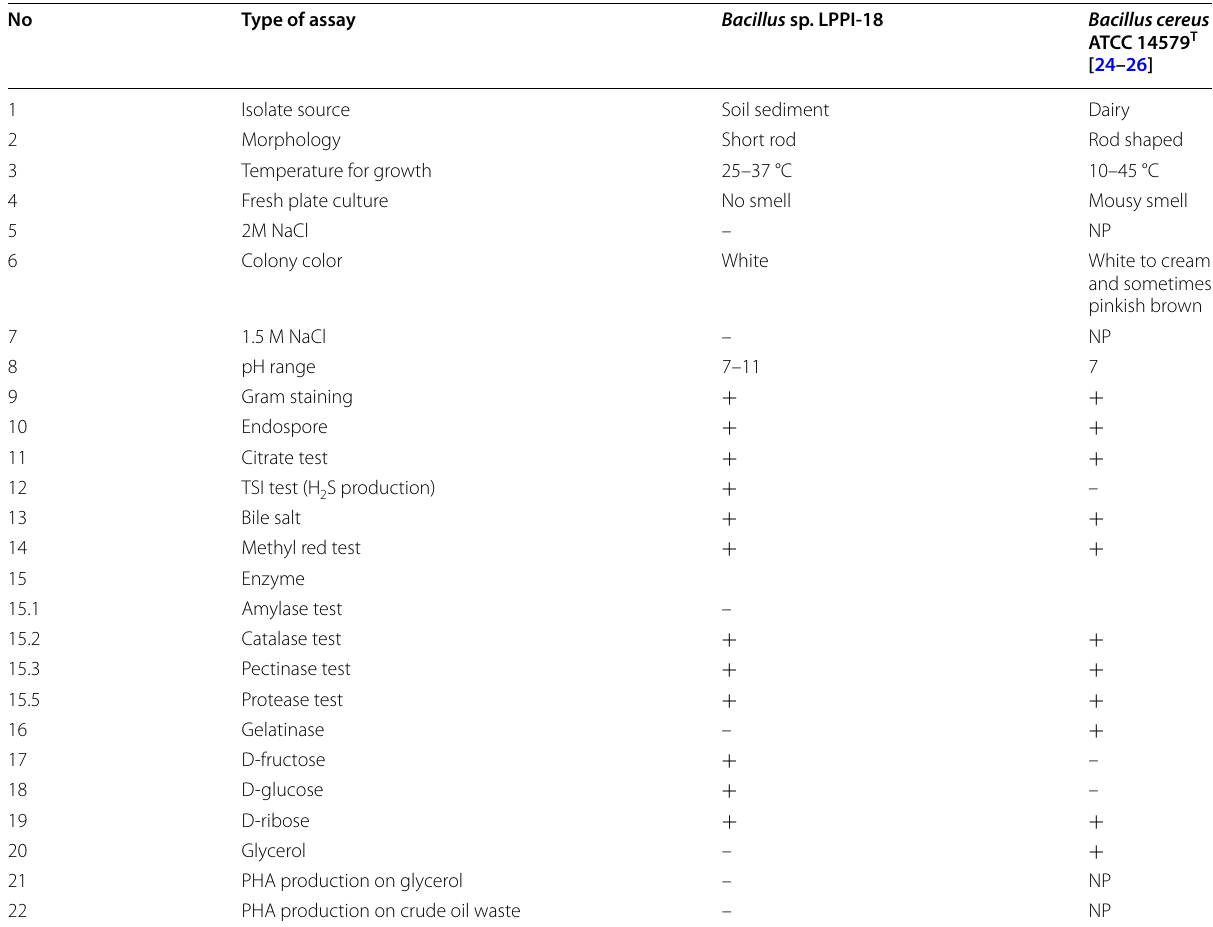
Table 1 Biochemical test and enzyme assay